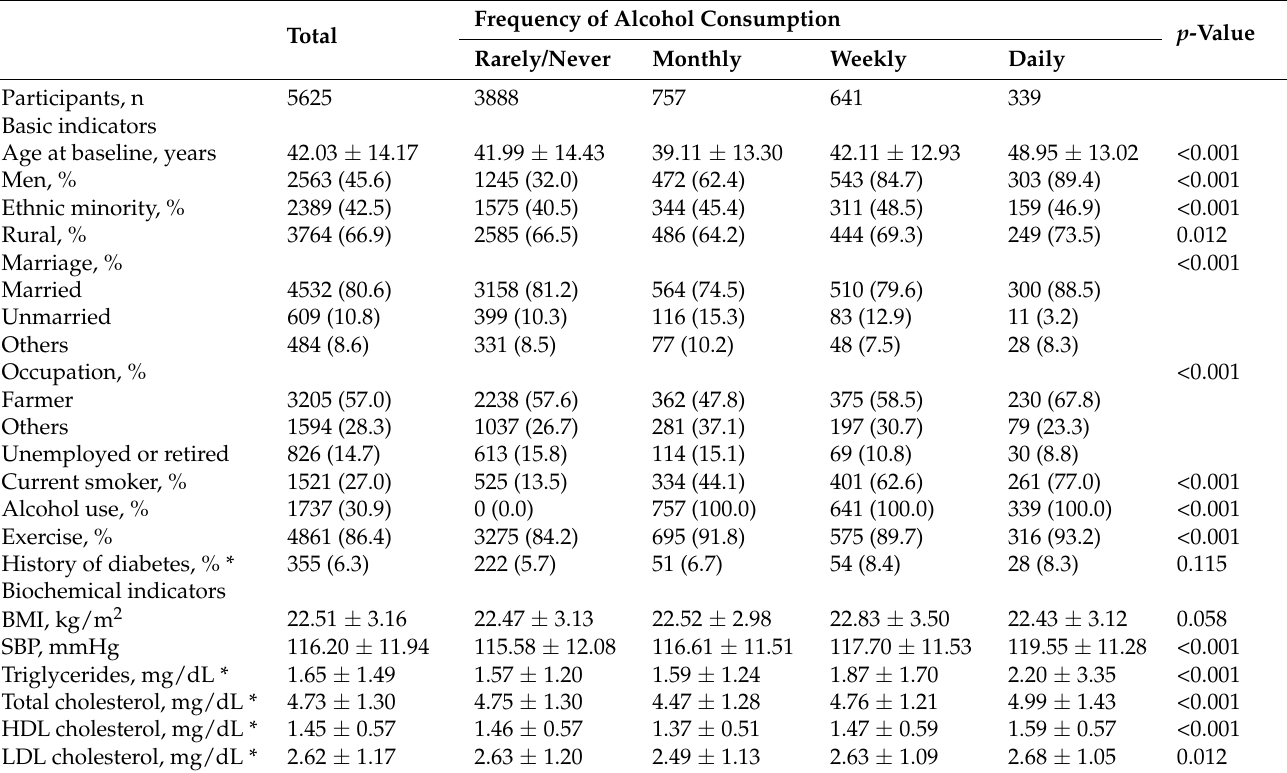
Table 1. Baseline characteristics according to the frequency of alcohol consumption. Frequency of Alcohol Consumption Total